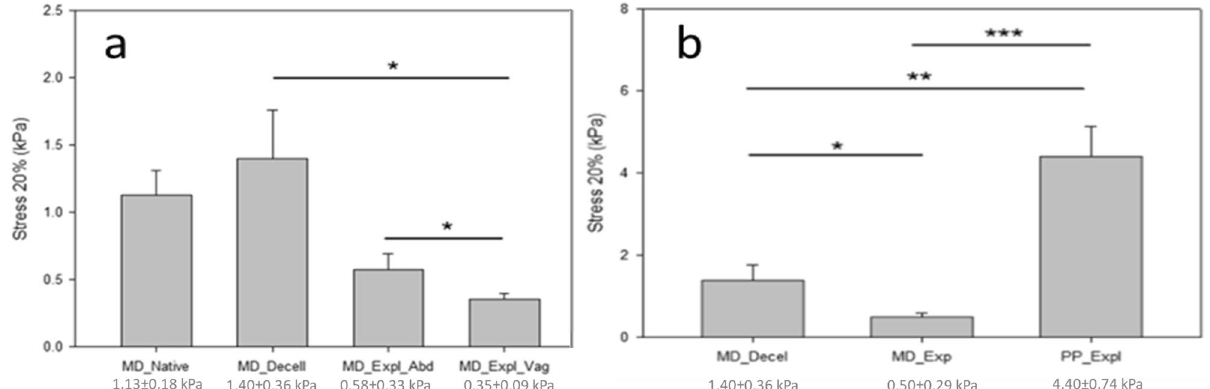
Figure 3. ( a ) Mechanical properties of the hADM grafts before and after their implantation. ( b ) Comparison of mechanical properties between explanted hADM and explanted PP mesh in the abdominal location. * p value < 0.05, ** p value < 0.01, *** p value <